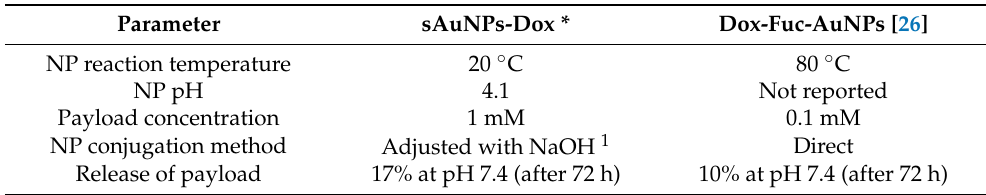
Table 2. Comparison of the doxorubicin-loaded sAuNPs (sAuNPs-Dox) vs. the fucoidan-capped AuNPs (Dox-Fuc-AuNPs) [26].